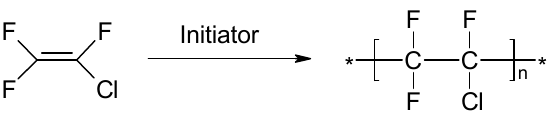
Figure 2. The polymerization of